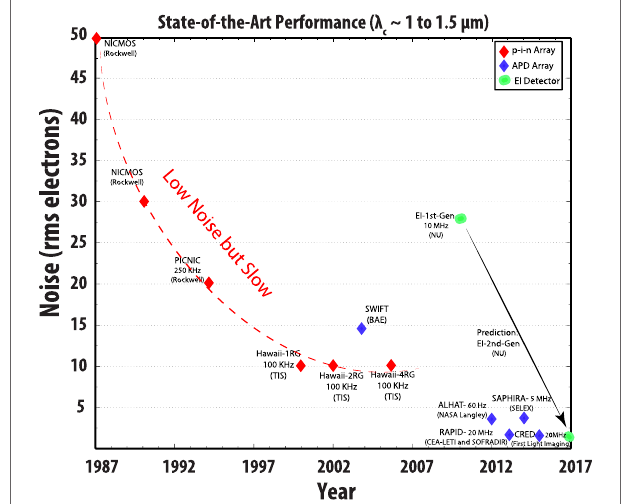
FiGURe 1 | The trend in noise reduction for state-of-the-art SwiR imaging arrays with cutoff wavelength ( λ c ) ~1–1.5 μ m over the past 30 years: the equivalent input noise of the ROiC determines the detection limit of the p–i–n detectors and has been nearly constant over the past 20 years. On the other hand, detectors with an internal amplification mechanism, such as the linear-mode avalanche photo diodes can reduce the input ROiC noise . Pixel rate is also indicated in this plot. APD technology allows for significantly higher pixel rates. With Northwestern University’s (NU) first-generation EI detectors and using an off-the-shelf CMOS ROIC with 575–870 electrons rms noise, the measured imager noise was reduced to 28 electrons rms at a frame rate of 1950 frames/s and at 0.5 ms integration time. On-going efforts are for the future development of large-format second-generation EI detector arrays with lower noise. Data obtained from Hodapp (2000), Bai et al. (2004, 2008b), Baker et al. (2004), Destéfanis et al. (2011), McKeag et al. (2011), Finger et al. (2012), Jack et al. (2012), and Feautriera et al.